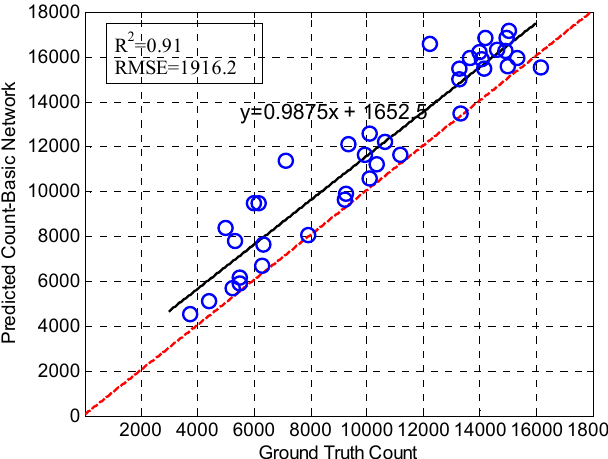
Figure 7. Manual counting versus automatic counting using our Basic Network model. The 1:1 line is dashed red. R 2 and RMSE represent the coefficient of determination and the root mean square error, respectively.